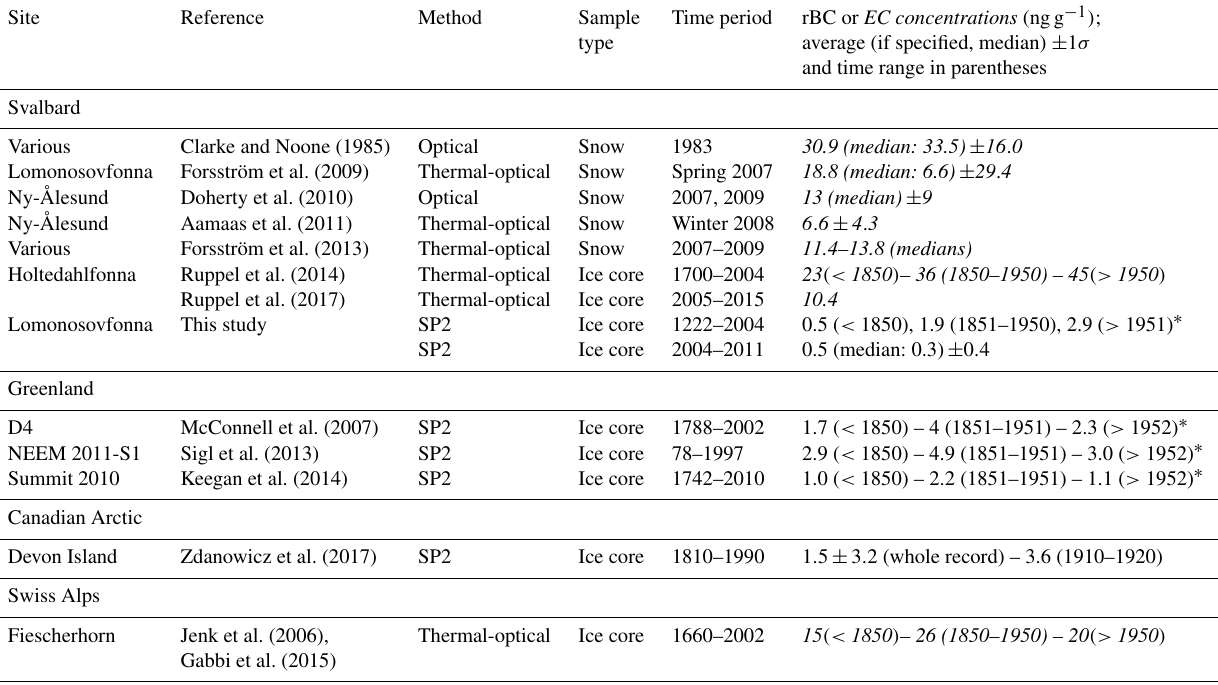
Table 1. rBC or EC concentrations (italic) from different ice core and snow studies in the Arctic and in Europe.